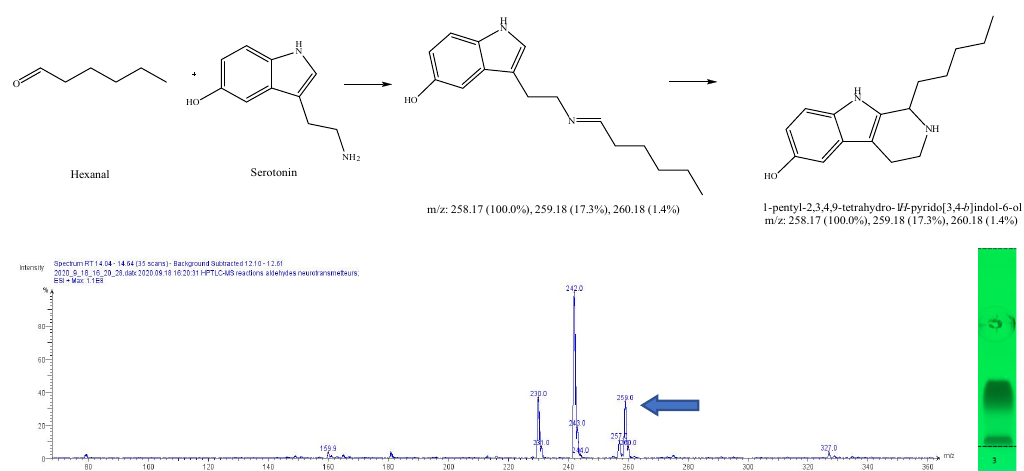
Figure 10. Expected reaction between dopamine and hexanal. Mass spectrum for the 1st spot of the reaction mixture on MS grade TLC plate.